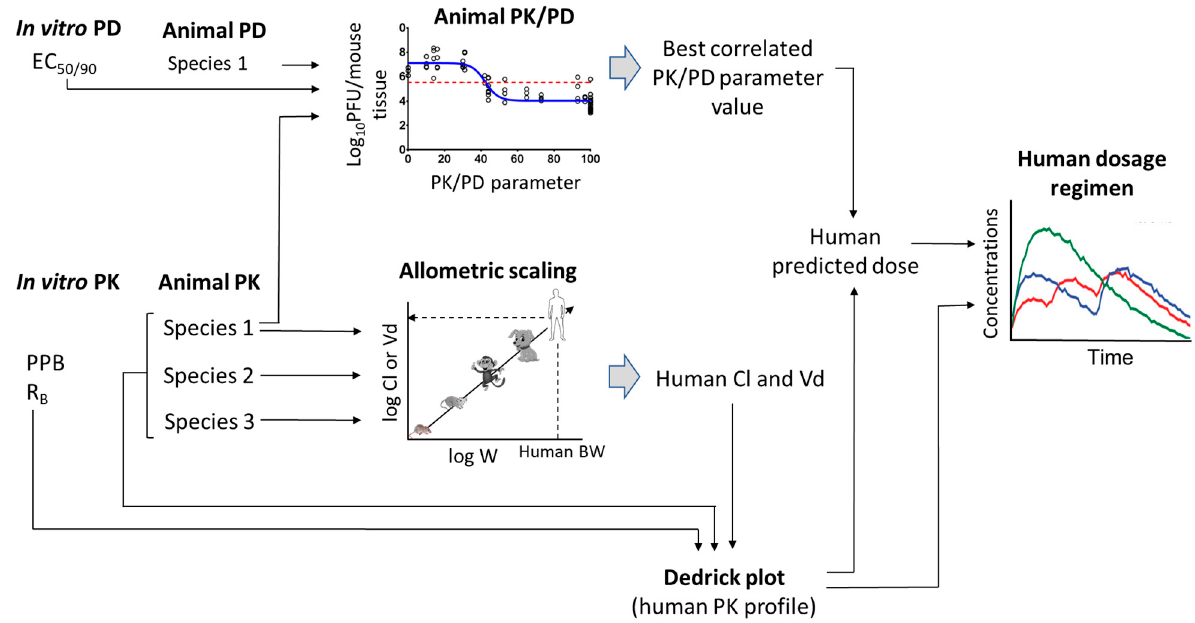
Figure 1. Graphical representation showing critical pathway from in vitro potency test to human dose prediction in discovery process.